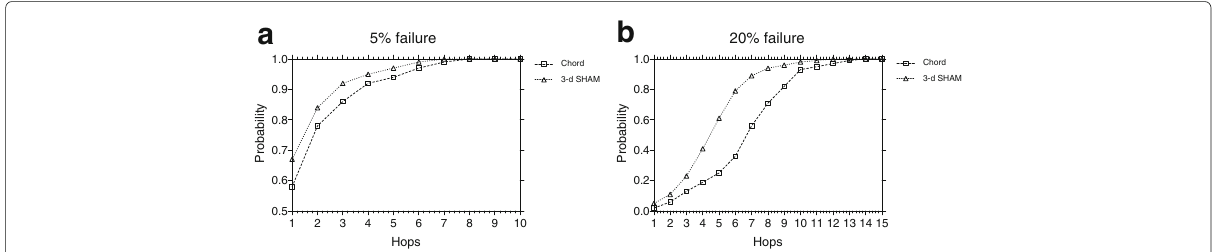
Fig. 11 Performance comparison between SHAM and Chord. CDF of number of additional hops visited in case a lookup encounters failed nodes in a network of 65,000 nodes. a Percentage of failed nodes is 5%. b Percentage of failed nodes is 20%